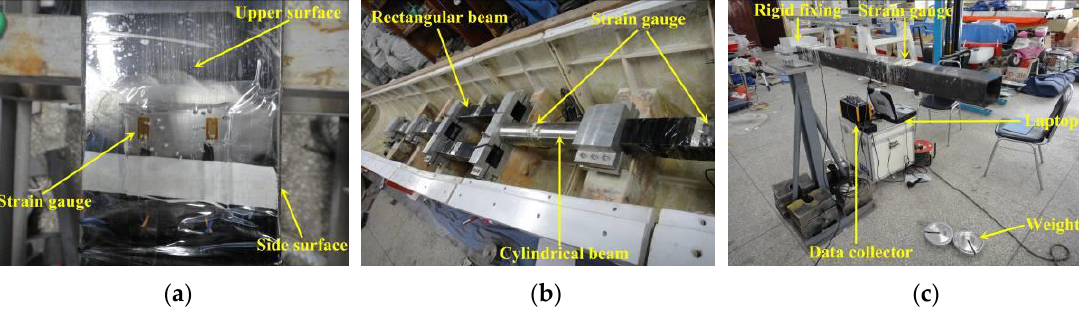
Figure 5. Backbone beams: ( a ) strain gauges on beam; ( b ) cylinder beam; and ( c ) beam stress calibration.